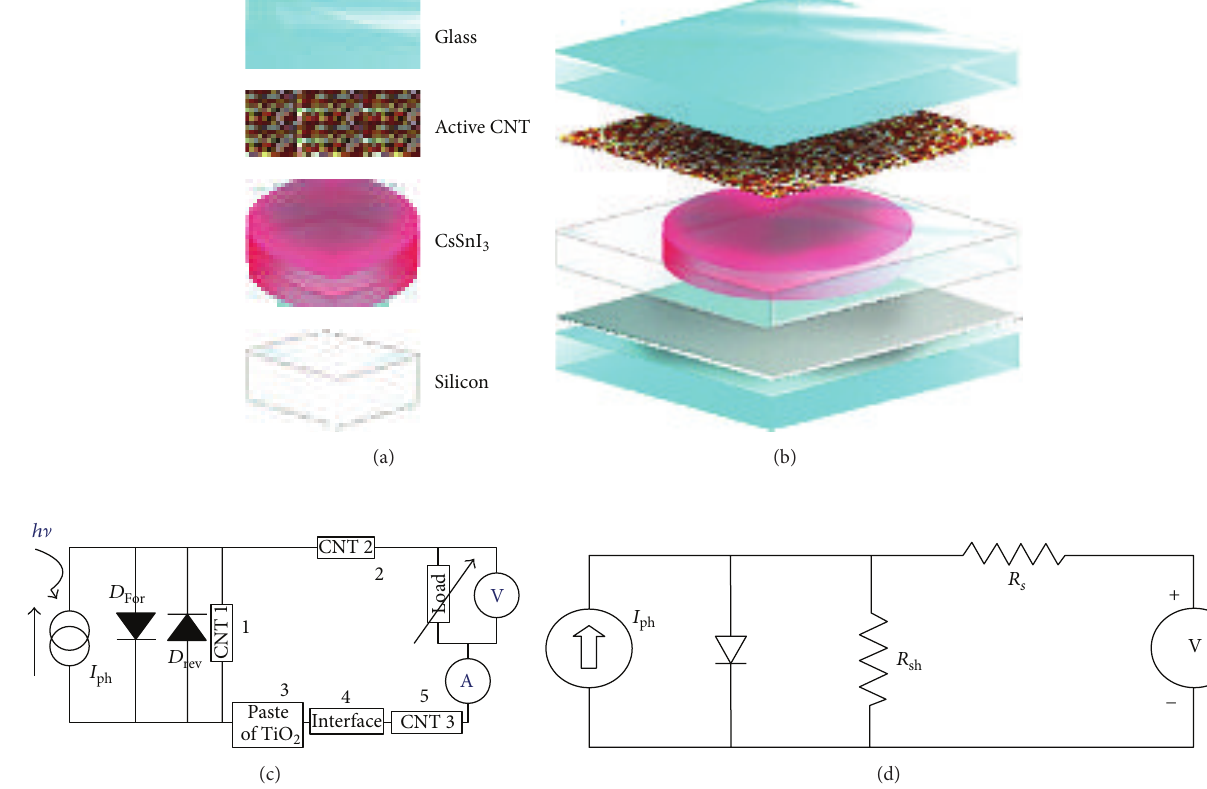
Figure 3: Schematic design of carbon nanotube solar cells (CNTSCs) and their equivalent electronic-circuits using the model of [36]. Figures 3(a) and 3(b) represent a CNTSCs construction where a glass slide (bluish-green) is followed by an active CNT film then film of CsSnI 3 with porous TiO 2 paste (red) followed by silicon insulator and CNT counter electrode (black) deposited on glass slide (bluish-green). Figure 3(c) shows the equivalent circuit of CNTSCs where the numbers stand for 1- Carbon nanotube film-1, 2- Carbon nanotube film-2, 3- Paste 4- interface 5- Carbon nanotube film-3 and 6- electric resistance load. The last part represents a typical “one-diode” equivalent circuit for a dye sensitized solar cell (DSSC). Figure 3(d) represents the equivalent circuit of typical one-diode